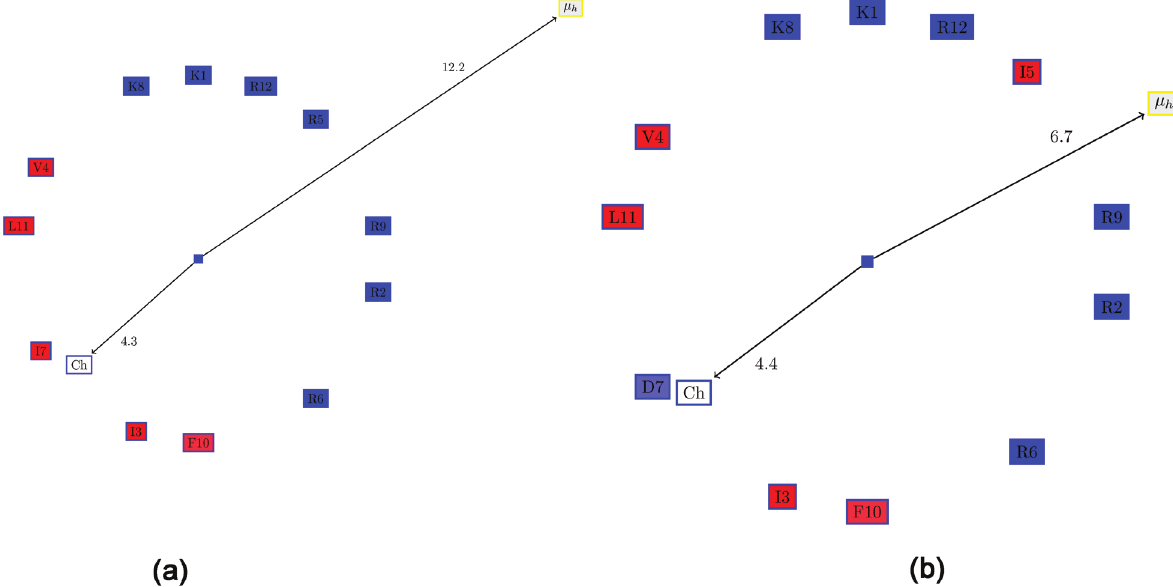
Figure 5. The problem in evaluating a ‘charge moment’ similar to the way the hydrophobic moment is computed. All hydrophobic residues are colored in red, while the hydrophilic residues are colored in blue: dark blue for positively charged residues, medium blue for negatively charged residues and light blue for amides. ( a ) Edmundson wheel of a KR-12 like peptide showing the hydrophobic moment and the ‘charge moment’. ( b ) Swapping one positive residue (R5) from the hydrophilic side with I7 and replacing it with a negative residue (D7), results in the same ‘charge moment’, although the characteristics of the helix has clearly